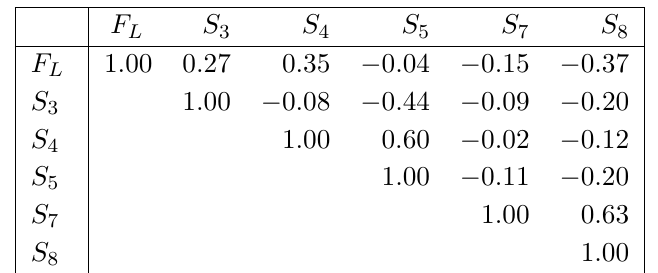
Statistical correlation matrix for the F